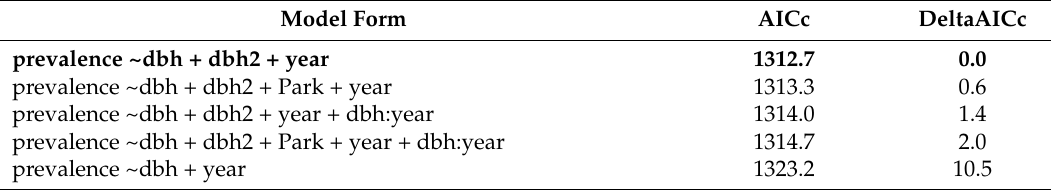
Table 5. Relative rating for top five generalized linear mixed effect models for predicting blister rust prevalence; the selected model is in bold . All models contain a random nested tree and plot effect. DeltaAICc is the difference in AICc from the top model.